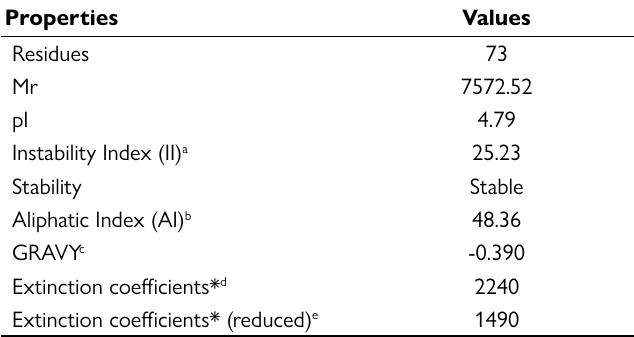
Table 2. Physicochemical properties of purpureomaculin from the Malaysian Trimeresurus purpureomaculatus